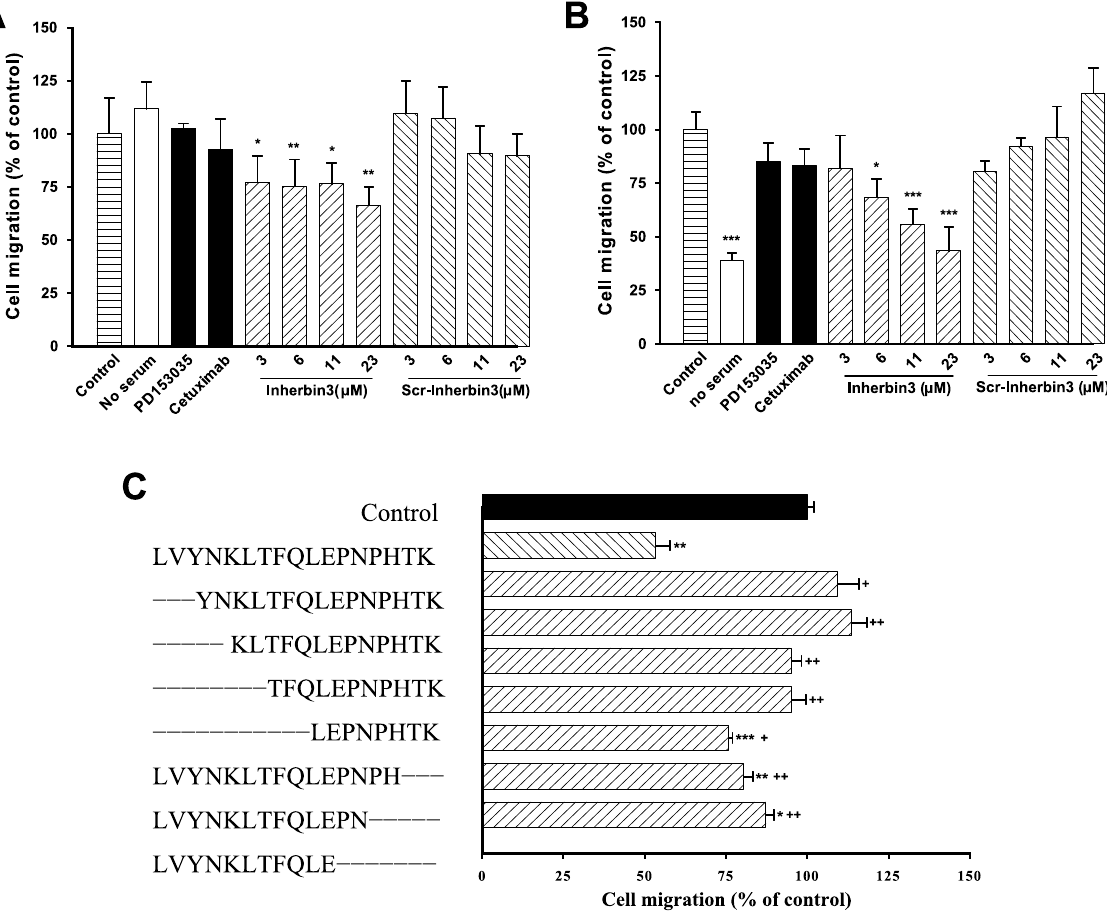
Fig. 6. Effect of Inherbin3 on HN5 and A549 cell migration. HN5 (A) or A549 (B and C) cells were seeded in serum-free medium containing Inherbin3 or scrambled Inherbin3 at the indicated concentrations, 100 nM PD153035, or 50 µg/ml Cetuximab. The concentration of Inherbin3 or truncated peptides from Inherbin3 in panel C was 11 µM. Cells were allowed to migrate for 24 h into the feeder tray containing medium supplemented with 10% serum (except in wells corresponding to the column “no serum” which contained serum-free medium in the feeder tray) and peptides and inhibitors at concentrations that were the same as in the corresponding migration chamber wells. Data are expressed as mean ± SEM of 4 independent experiments. ∗ p < 0 . 05, ∗∗ p < 0 . 01, ∗∗∗ p < 0 . 001, significant difference compared with untreated cells (control) (Student’s paired t -test). + p < 0 . 05, ++ p < 0 . 01, significant difference compared with Inherbin3 (Student’s paired t